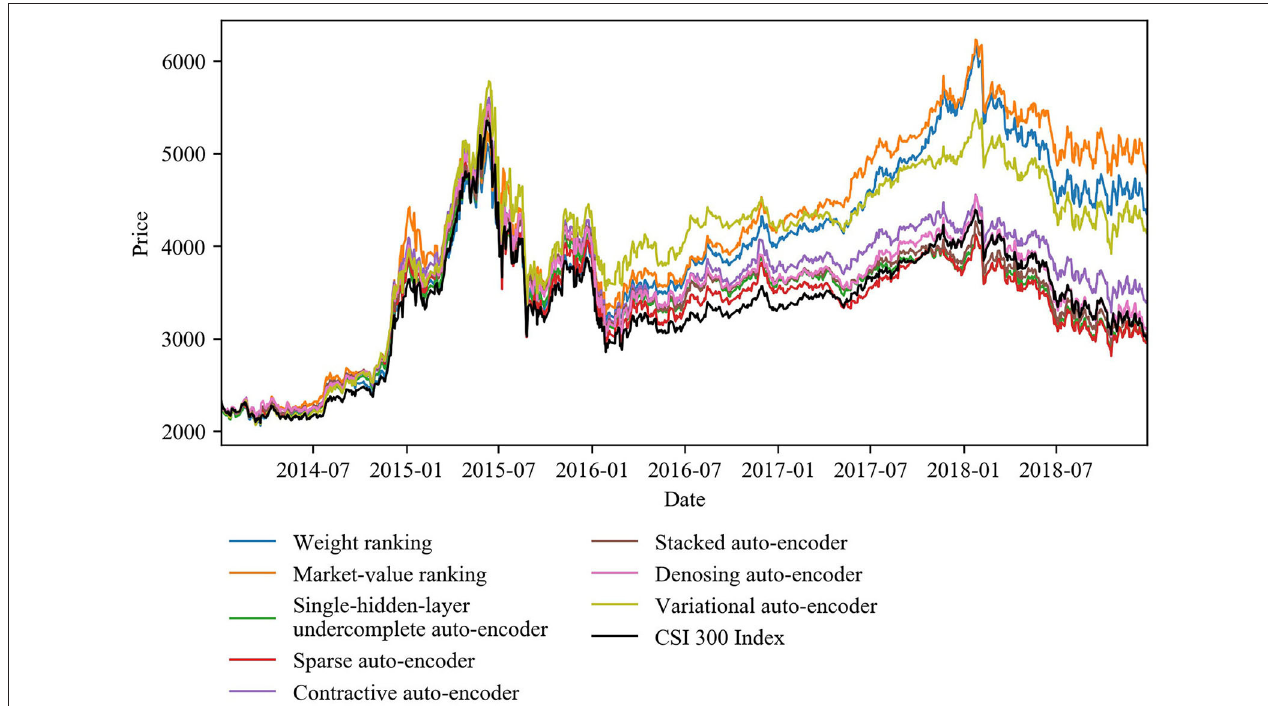
FIGURE 11 | Out-of-sample cumulative return curves of the CSI 300 Index and the 25-stock tracking portfolios constructed by all strategies covered by this study.